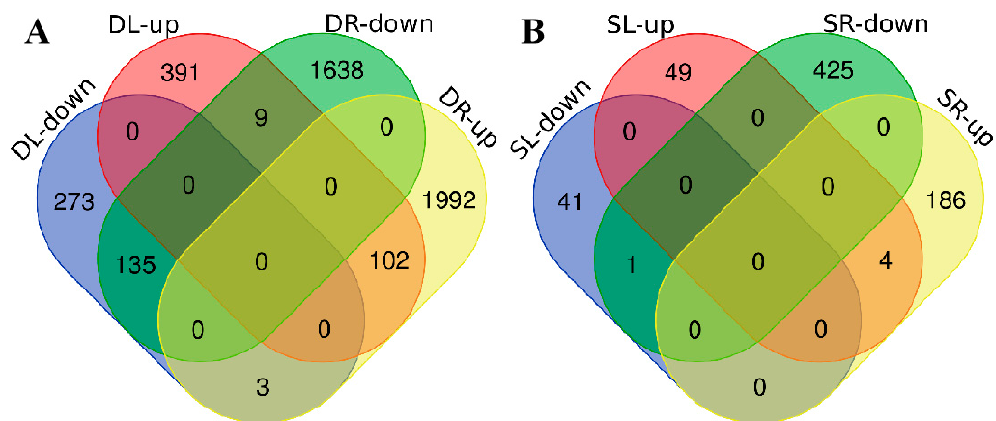
Figure 2. Venn diagrams of differentially expressed genes (DEGs). ( A ) DEGs between the control (CK ) and drought (simulated by PEG) treatment. DL-down/DR-down indicate downregulated DEGs in leaves/roots under PEG treatment compared to the control. DL-up/DR-up indicate upregulated DEGs in leaves/roots under PEG treatment compared to the control. ( B ) SL-down/SR-down indicate downregulated DEGs under NaCl treatment compared to the control. SL-up/SR-up indicate upregulated DEGs under NaCl treatment in leaves/roots compared to the control.